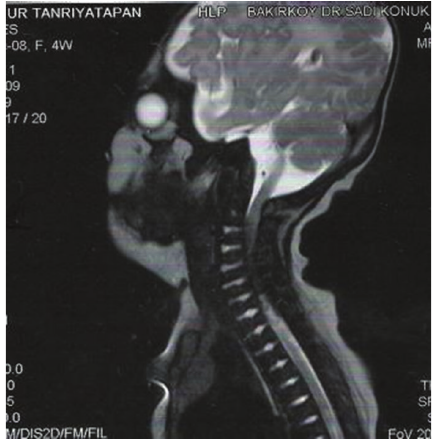
Figure 2: On the cervical spinal MRI, spinal stenosis at C4-5, C5-6, and C6-7